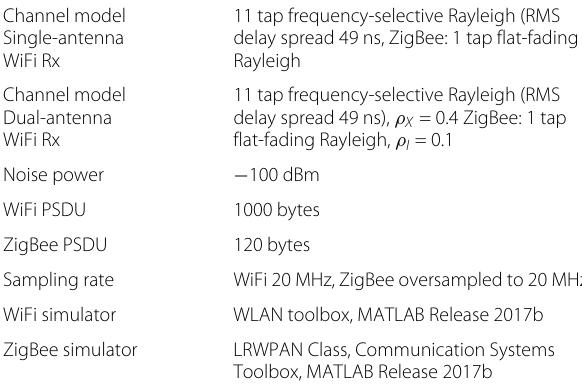
Table 1 Simulation parameters Channel model